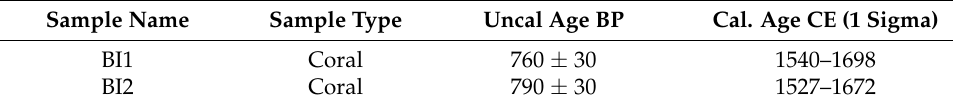
Table 2. Radiocarbon dates for samples from Belang